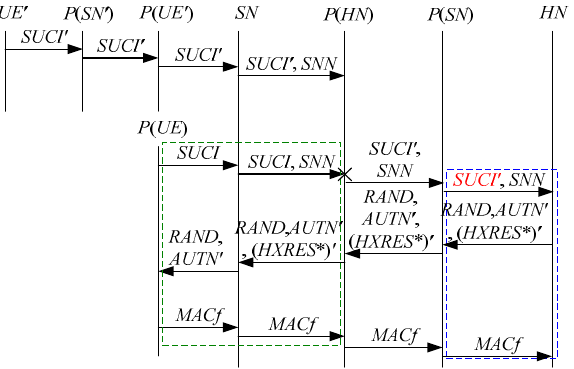
Figure 22. The twenty-first attack scenario of the 5G AKA protocol.